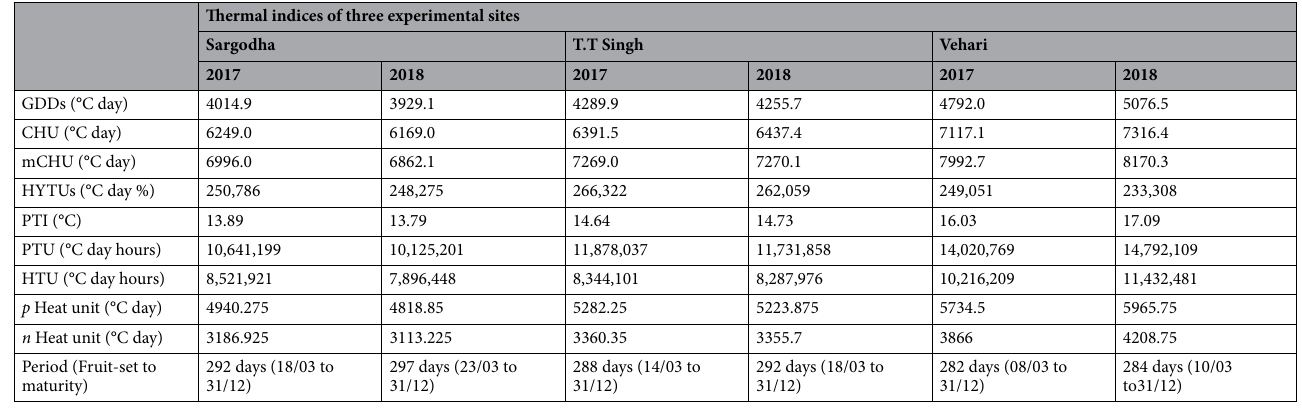
Table 2. Thermal indices of experimental sites. GDDs (growing degree days), CHU (citrus heat unit), mCHU (modified citrus heat unit), HYTUs (hydrothermal units), PTI (photothermal index), PTU (photo thermal